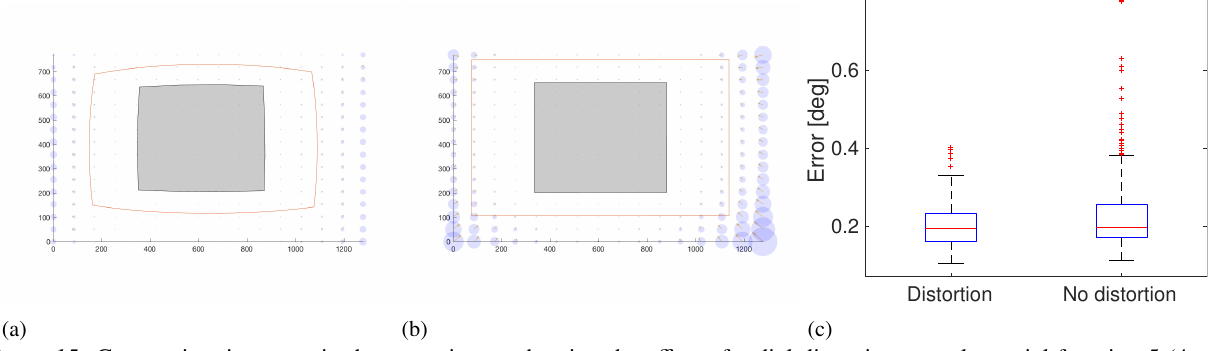
0 . 5 with PCR method. No radial distortion was included and the noise was added both during and after the